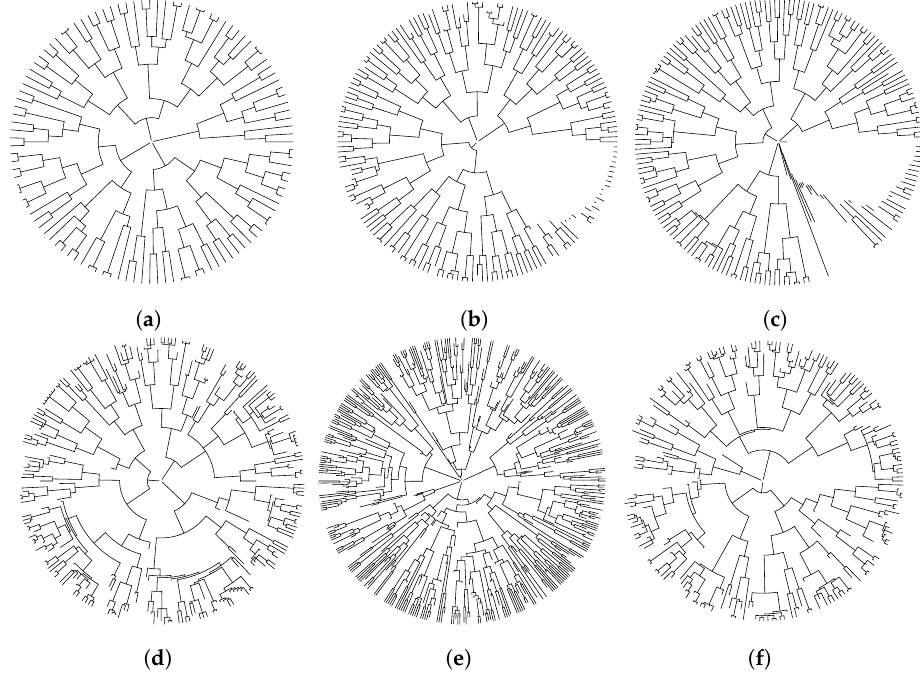
Figure 6. A comparison of six lineage trees. They were generated from the parent-child relationship provided for each cell found in each frame. Gaps in the lineage trees, resulting from cells being temporarily untracked for several frames, were filled in. Time starts at the center of the disk and proceeds outwards. ( a ) Cell Universe Lineage Tree; ( b ) SuperSegger Lineage Tree; ( c ) Lineage Mapper Lineage Tree; ( d ) CellProfiler Lineage Tree; ( e ) TrackMate Lineage Tree; ( f ) TLM-Tracker Lineage